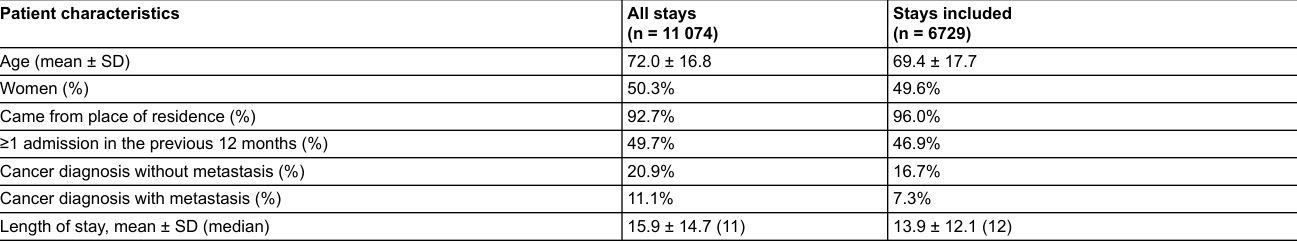
Table 1: Patient characteristics of stays included in the analysis (n = 6729) compared with total stays (n = 11 074).